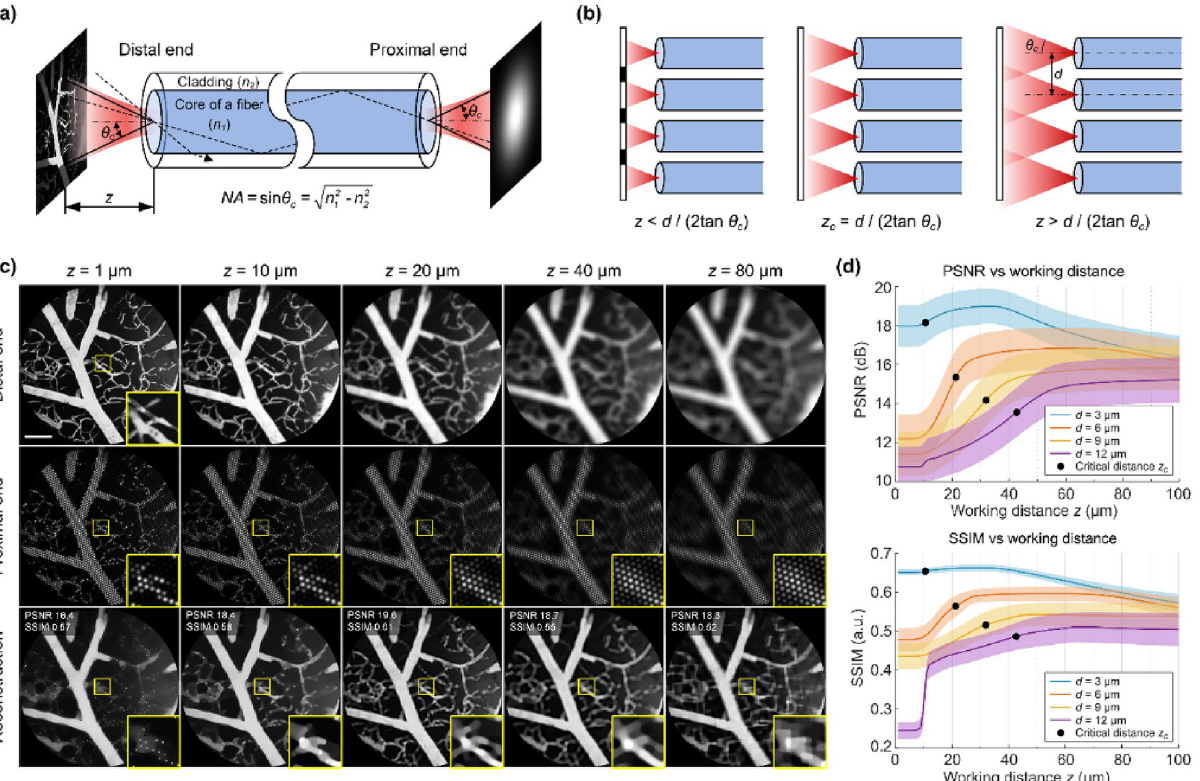
Figure 2. Optimal working distance for reconstruction. ( a ) Schematic of the transmission of an image by optical fiber as a single pixel. The working distance z and NA of fiber determine a cone space in which light can be coupled into fiber. ( b ) The situation that CFB gather light from sample under different working distance z. Areas that can be illuminated by and that can contribute to the intensity in each fiber core for different working distances. ( c ) The images at two ends of CFB and reconstructed images under different working distances. The reconstruction method is compressive sensing with TV regularization. Scale bar: 30 μm. Free space image propagation and deterioration by the CFB are realized numerically. ( d ) PSNR and SSIM distributions at varying working distances over 10 images of mouse cortical vasculature. Plotted are the mean (line) and 95% confidence interval (shading). The black dots indicate the critical